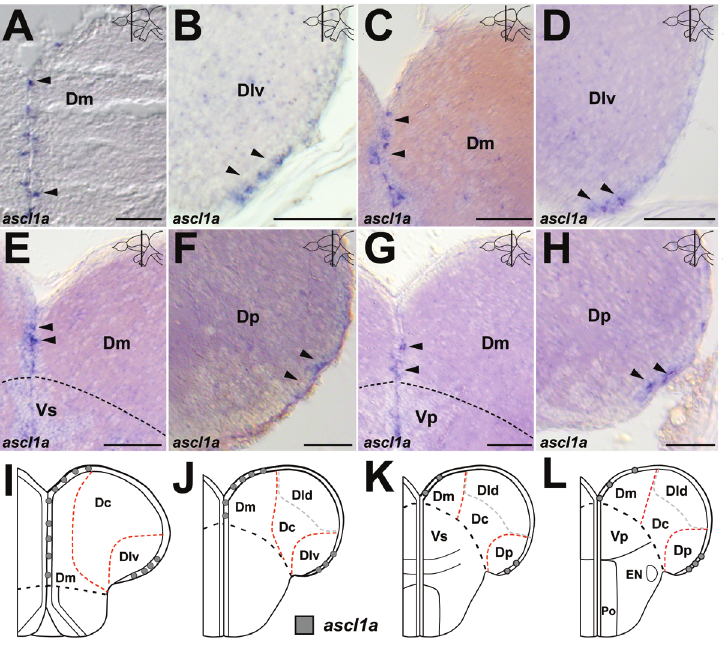
Figure 4. Expression of ascl1a in the pallium. A .– B . In the rostral telencephalon, ascl1a expression is present in scattered cells in the ventricular zone (vz) of Dm ( A , arrowheads) and Dlv ( B , arrowheads). C .– D . At mid-telencephalic levels, ascl1a expression is present in scattered cells in the vz of Dm ( C , arrowheads) and Dlv ( D , arrowheads). E .– F . At Cant, ascl1a expression is present in scattered cells in the vz of Dm ( E , arrowheads) and Dp ( F , arrowheads). G .– H . Posterior to Cant, ascl1a expression is present in scattered cells in the vz of Dm ( G , arrowheads) and Dp ( H , arrowheads). I .– L . Summary of the expression pattern of ascl1a rostral ( I .), mid-telencephalic ( J .), commissural ( K .) and postcommissural levels ( L .). A .– H . Brightfield images of cross-sections at the levels indicated through the telencephalon. Red dashed line indicates subdivisions based on the current marker. White dashed line indicates subdivisions based on other markers. The black dashed line indicates the boundary between D and V. Scale bars = 50µm in A – C